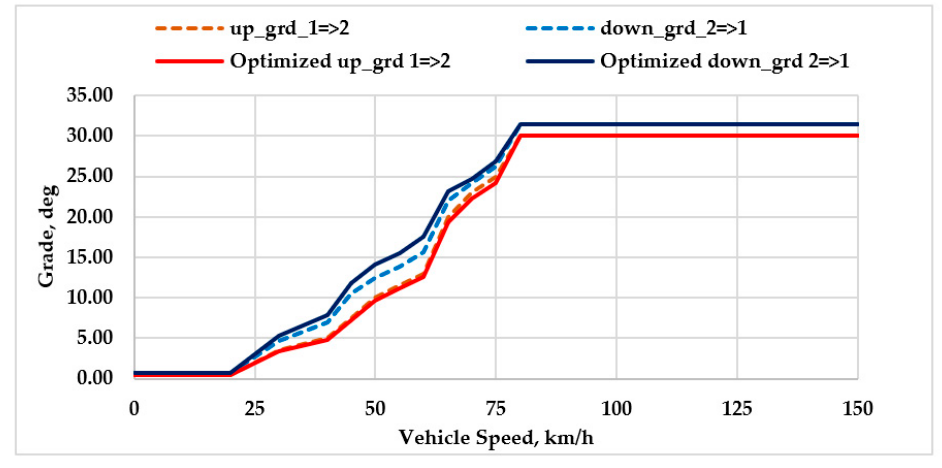
Figure 16. Gearshift schedule in relation to road grade before and after optimization.